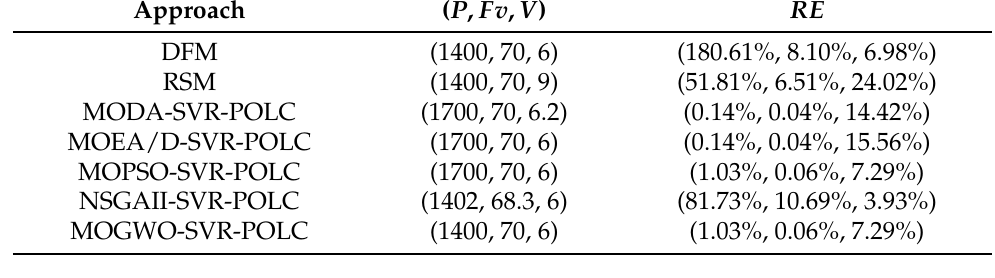
Table 6. Optimal process parameters and relative errors ( RE ) of the comparison methods.